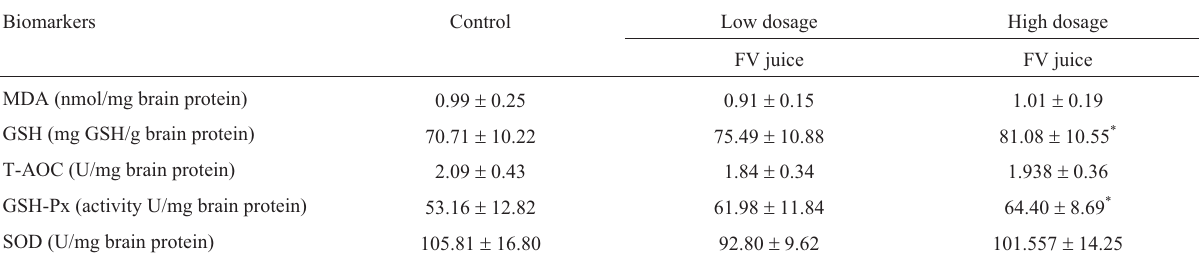
Table 2 - Effects of fruit and vegetable (FV) juice dietary intervention on MDA, GSH, T-AOC levels, GSH-Px and SOD enzyme activities in rat liver tis- sue. Biomarkers Control